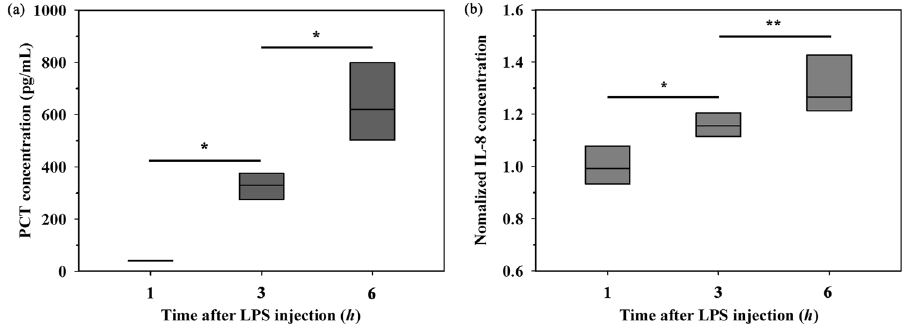
Figure 5. Variation in biomarkers for PCT and IL-8 extracted from a rat extracorporeal model. Comparison of biomarkers ( a ) PCT and ( b ) IL-8 in the plasma according to the lapsed time after LPS injection. ( * p < 0.01 and ** p < 0.005: significant difference between